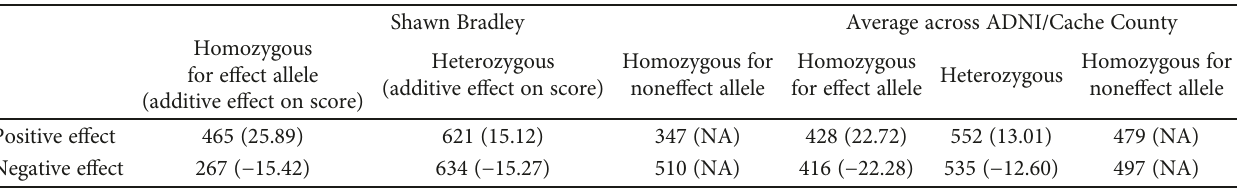
Table 2: Genotype counts for e ff ect alleles in Shawn Bradley and the ADNI/Cache County populations.